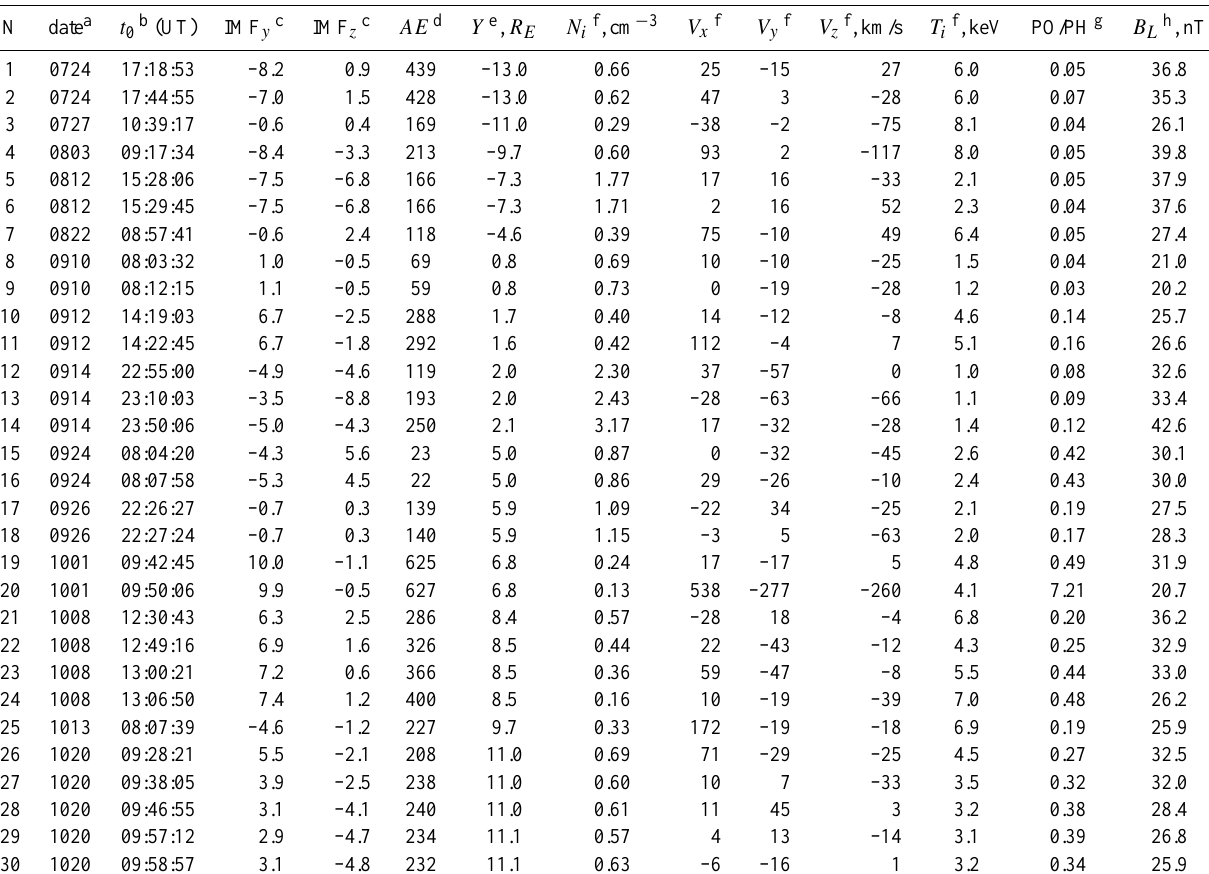
Table 1. Selected